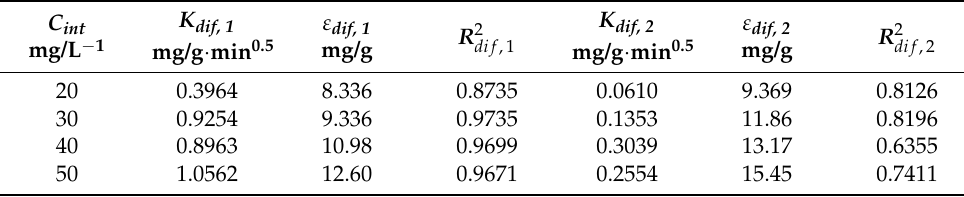
Table 2. The parameters of the interparticle diffusion model of methyl blue